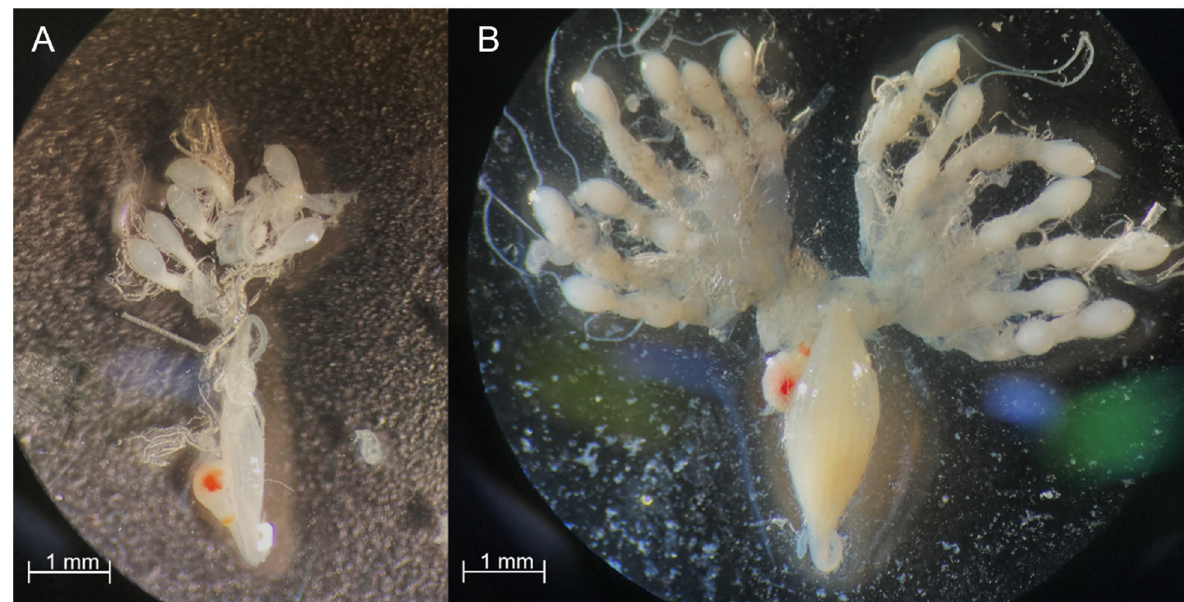
Figure 1. Halyomorpha halys female reproductive system. ( A ) Rank 2: previtellogenic female, more than one immature oocytes per ovariole, spermatheca clear and skinny. ( B ) Rank 3: vitellogenic female (control), at least one mature oocyte per ovariole, spermatheca distended (Images 2,5x magnification).